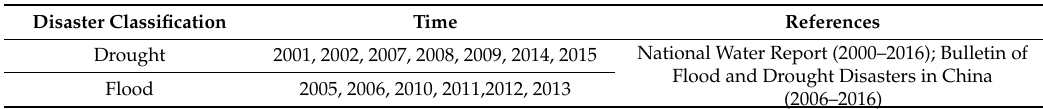
Table 7. Disaster situation in the study area obtained from